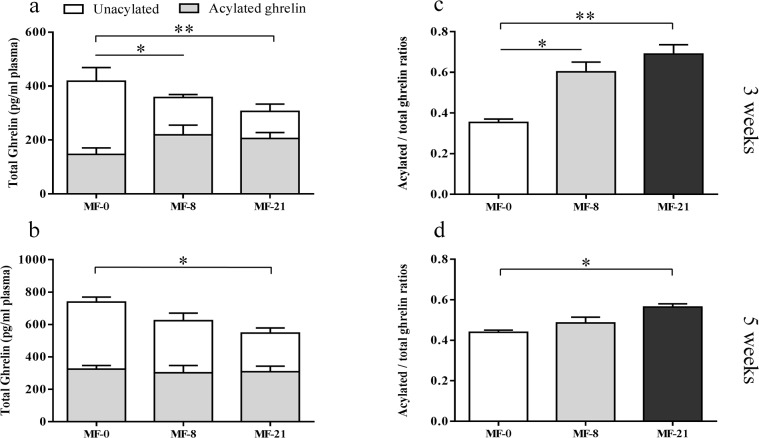
Effect of dietary tricaprylin level on the plasma acylated and unacylated ghrelin concentrations, in the MF groups (fed state).(a) Acylated and unacylated ghrelin concentrations after 3 weeks of diet. Kruskal-Wallis test (K-W): (i) acylated ghrelin, P = 0.44; (ii) unacylated ghrelin, P = 0.0018, Dunn’s post tests, *P<0.05, **P<0.01; (iii) total ghrelin, P = 0.5824. (b) Acylated and unacylated ghrelin concentrations after 5 weeks of diet. K-W test: (i) acylated ghrelin, P = 0.56; (ii) unacylated ghrelin, P = 0.029, Dunn’s post tests, *P<0.05; (iii) total ghrelin, P = 0.127. (c) Acylated/total ghrelin ratios after 3 weeks of diet. K-W test: P = 0.006, Dunn’s post tests, *P<0.05, **P<0.01. (d) Acylated/total ghrelin ratios after 5 weeks of diet. K-W test: P = 0.0103, Dunn’s post tests, *P<0.05.